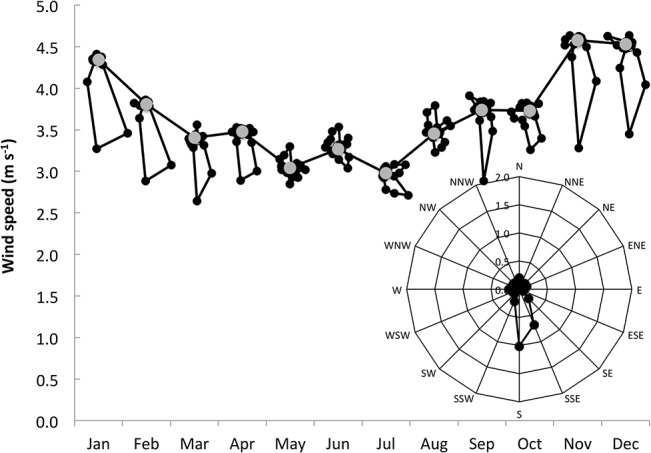
The variation in monthly average wind speed from the Geelbek weather station at the West Coast National Park that is 2.2 km from the mid-point of the transect (Fig 1).The wind-roses for each month are shown with their center points being the average wind speed (grey point). The inset wind-rose shows the average annual wind speed and direction on the same scale as used for the monthly data.